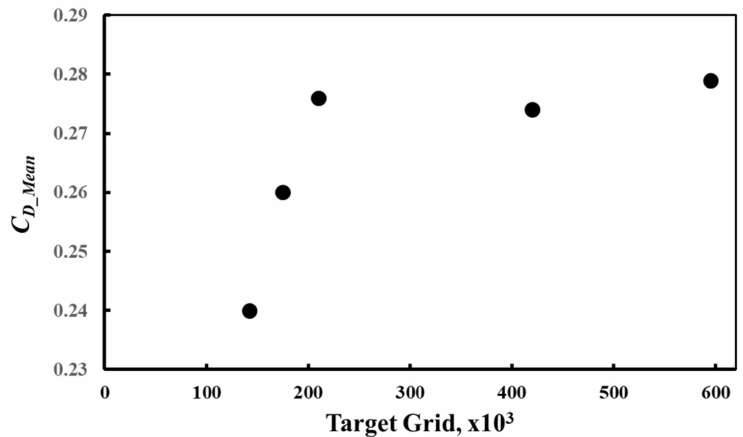
Figure 2. C D _ Mean for the grid independency study.